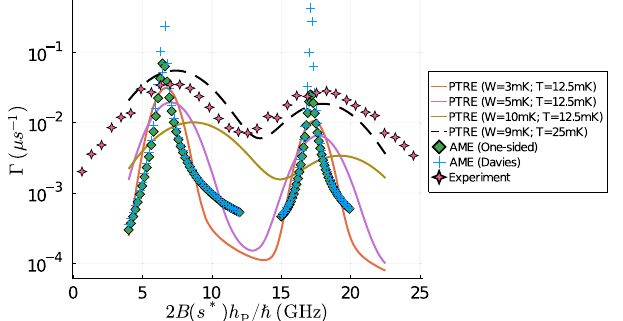
Fig. 4 Tunneling rates obtained via different master equations compared with the experimental results. The bath coupled to the system qubits is = _ 2 ¼ 1 : 2732 ´ 10 (cid:3) 4 , f = 4GHz and Ohmic with parameters: η g 2 c S T = 12.5mK. The corresponding models and parameters of the bath coupled to the probe qubit used for different simulations are i. adiabatic master equation (AME): Ohmic with g P = 10 g S and s (cid:6) ¼ 0 : 612. ii. polaron p transformed Red fi eld equation (PTRE): hybrid-Ohmic with g P = 10 g S and various W , T values. The cutoff frequency f c is the same across different models. Here too s (cid:6) ¼ 0 : 612. iii. PTRE with alternative parameters (black p dashed line): hybrid-Ohmic with W = 9mK, T = 25mK, and s (cid:6) ¼ 0 : 59, p while the other parameters are the same as in case